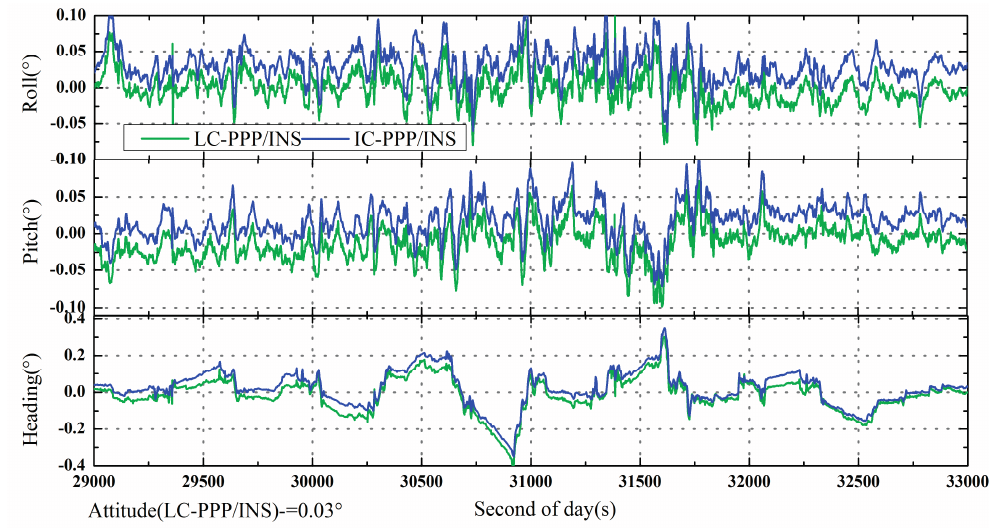
Figure 5. Attitude differences of the LC-PPP/INS and IC-PPP/INS (forward processing) with respect to the solution of IE software. The LC-PPP/INS differences are shifted by − 0.03° for clarity.